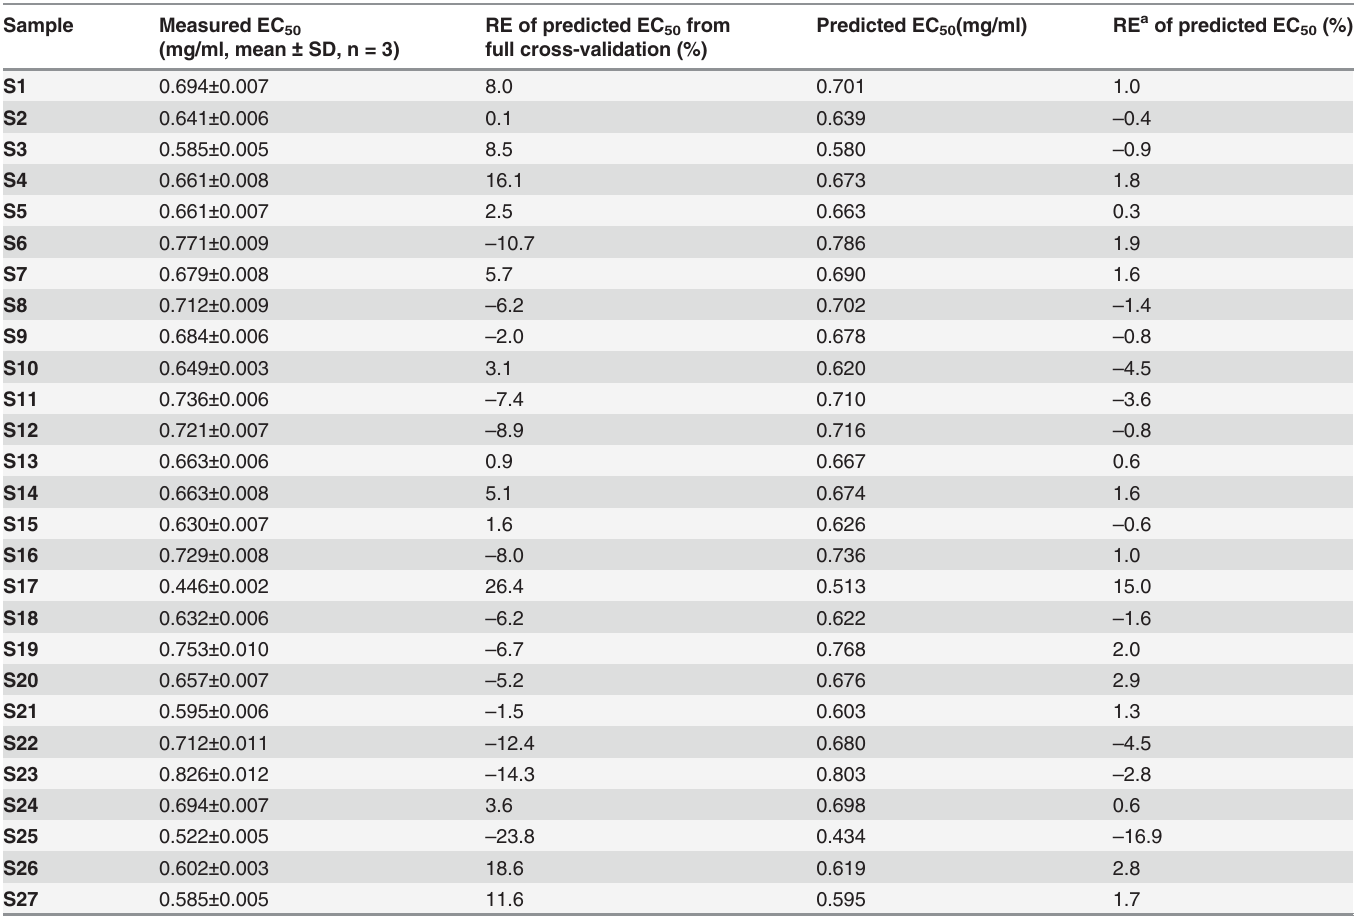
Table 4. The measured and predicted EC50 values for 27 CBAT samples.